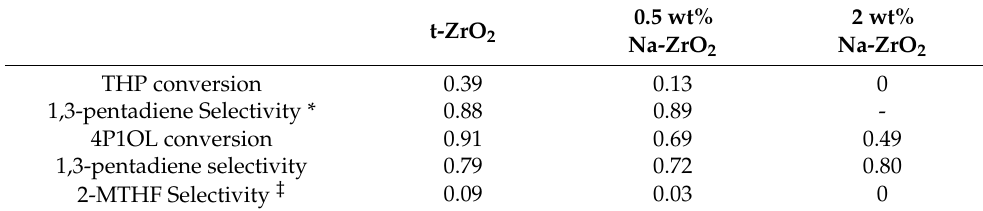
Table 2. Conversion and selectivity for reaction of THP (WHSV = 2.22 g THP/g cat/h, 673 K)